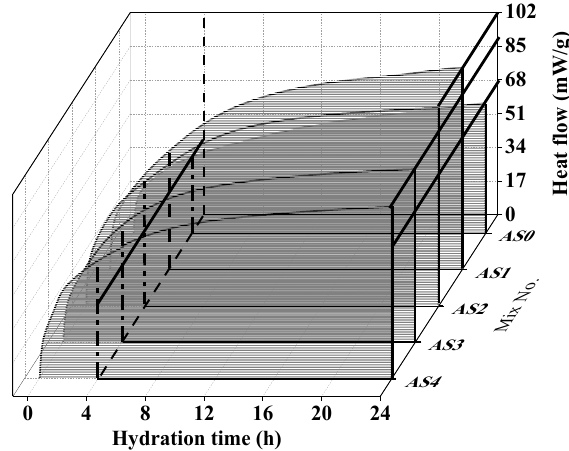
Figure 6. Effect of aluminum sulfate on the accumulated hydration heat.